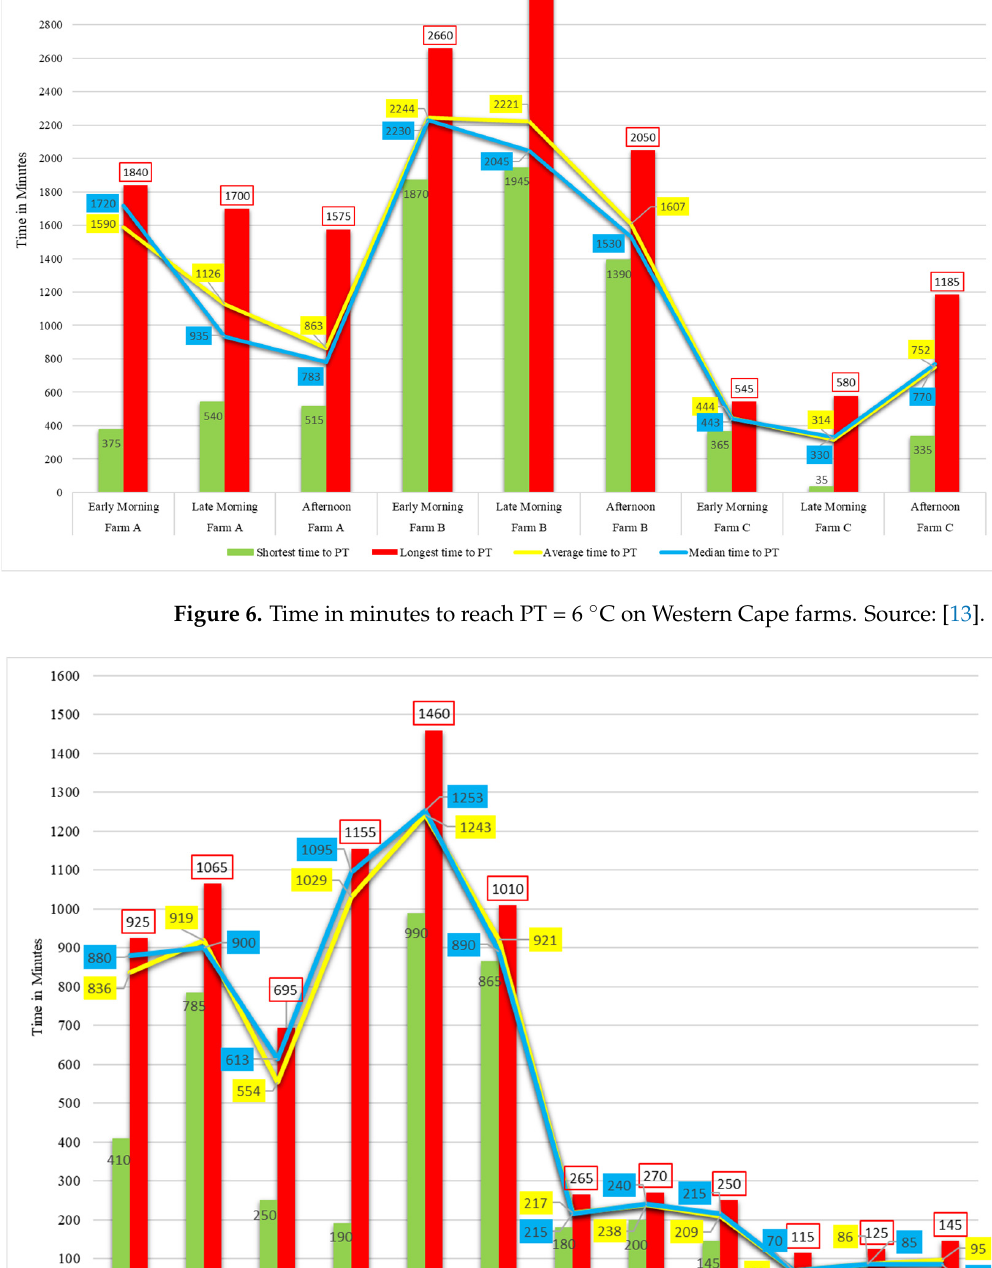
Figure 8. Stage during which PT = 6 °C was reached on Western Cape farms. Source: [13].